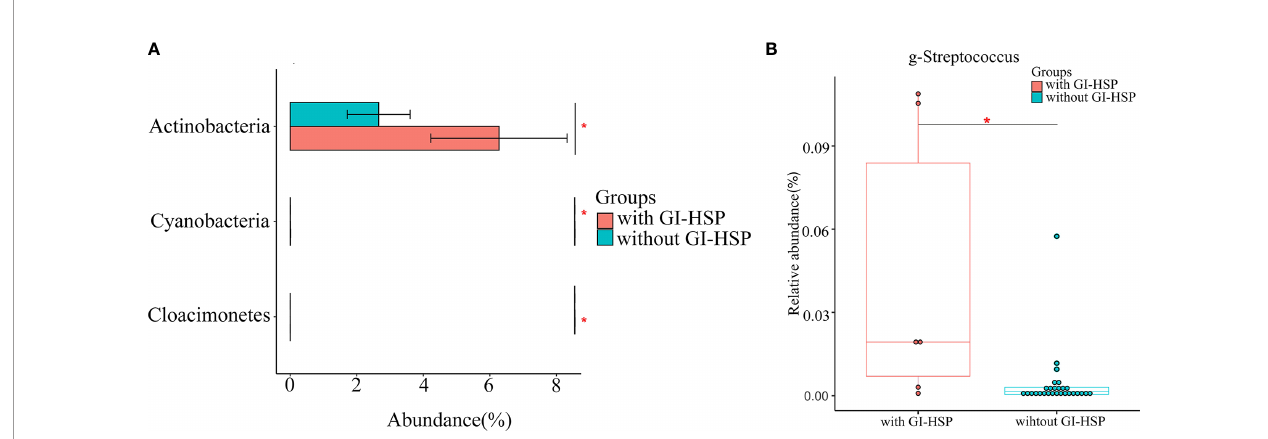
FIGURE 5 | Relative abundance (%) and taxonomic differences of gut microbiota in HSP patients with and without abdominal pain. (A) The relative abundance of the phylum Actinobacteria in patients without GI involvement was signi fi cantly lower than that in patients with GI involvement. (B) The relative abundance of Streptococcus in each sample. Box and whisker plots show that Streptococcus relative abundance was signi fi cantly increased in patients with GI involvement compared with those in patients without GI involvement. * P < 0.05.